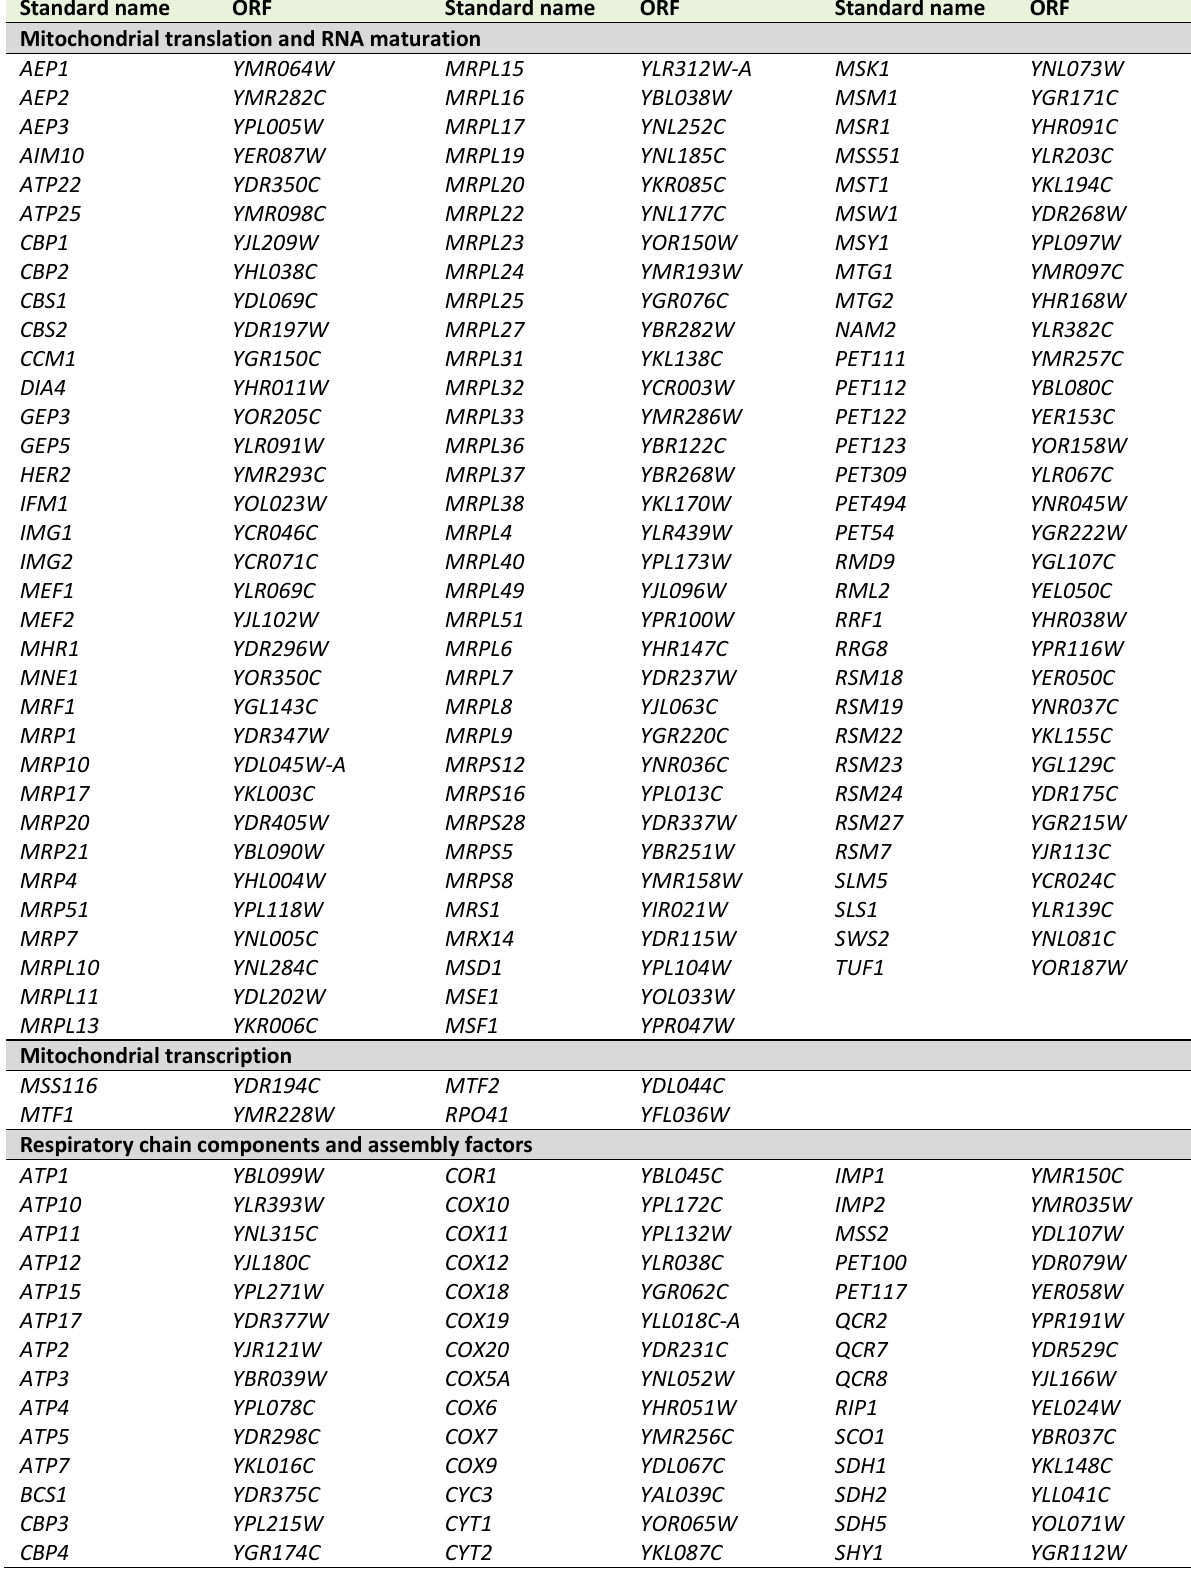
TABLE 1. High confidence pet genes in yeast. Genes were manually grouped into the functional categories shown in Figure 1C. More de- tails can be found in Tables S1 and